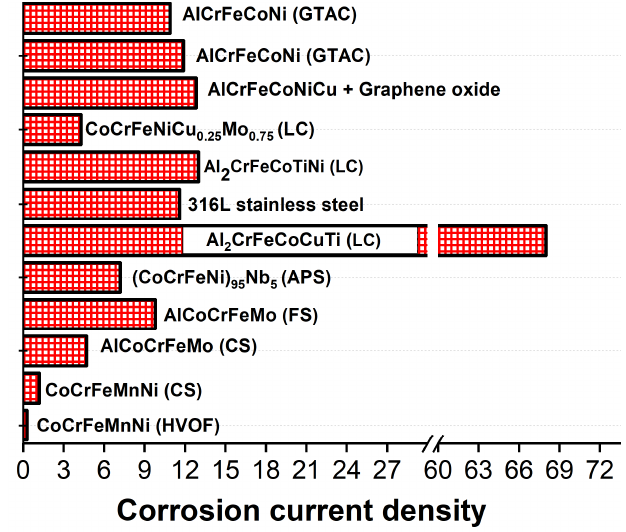
Figure 17. A comparative assessment of corrosion current density for thermally sprayed HEA coatings with other HEA coatings fabricated using different methods under 3.5 wt% NaCl solution [59,96,97,99,102–105]. The thermal-sprayed HEA coatings showed lower corrosion rates compared to stainless steel 316L and other HEA coatings. GTAC is gas tungsten arc cladding, CS is cold spraying, FS is flame spraying, HVOF is high-velocity oxy-fuel, APS is air plasma spraying, and LC is laser cladding.